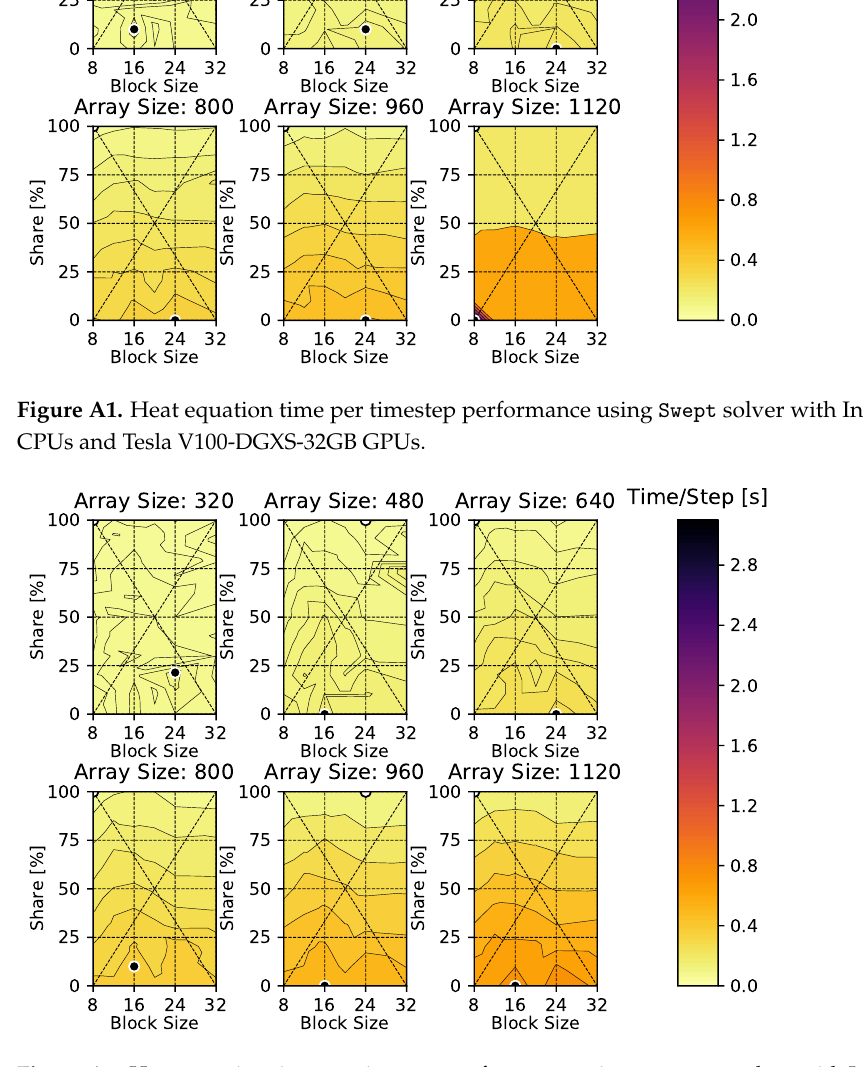
Figure A2. Heat equation time per timestep performance using Standard solver with Intel E5-2698v4 CPUs and Tesla V100-DGXS-32GB